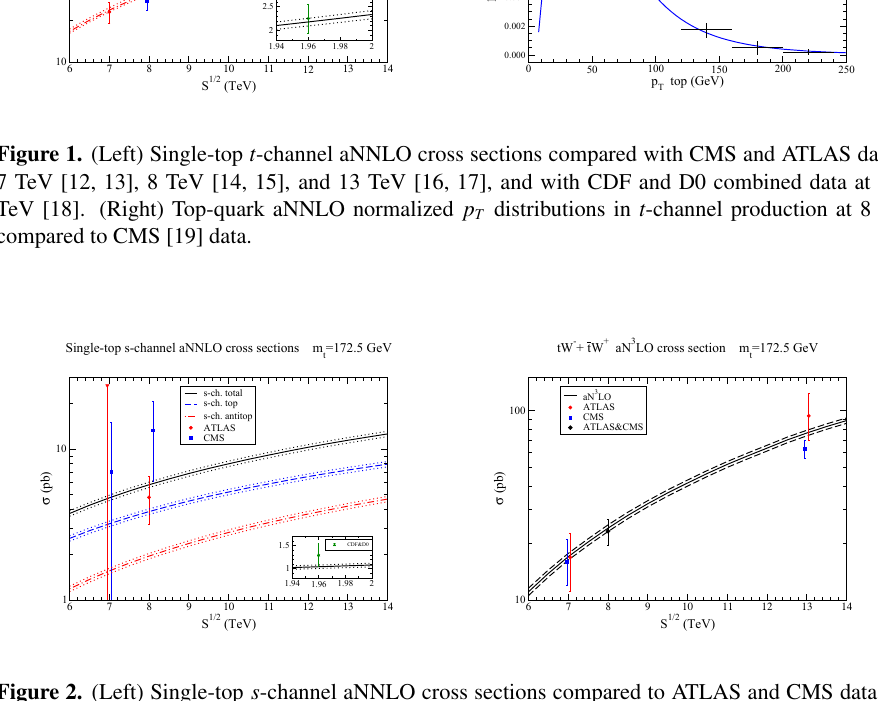
Figure 2. (Left) Single-top s -channel aNNLO cross sections compared to ATLAS and CMS data at 7 TeV [20, 21] and 8 TeV [21, 22], and to CDF and D0 combined data [23] at 1.96 TeV. (Right) aN 3 LO cross sections for tW production compared to ATLAS and CMS data at 7 TeV [24, 25], 8 TeV [26], and 13 TeV [27,